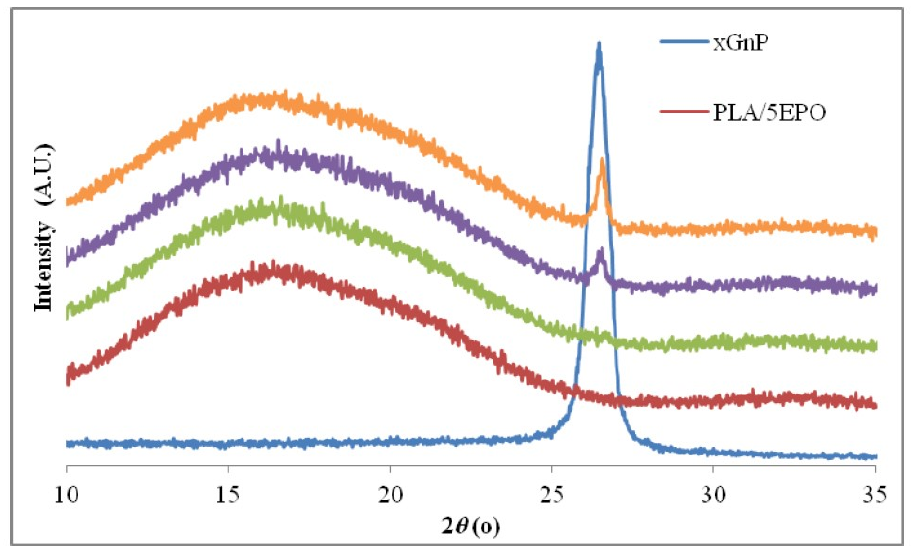
Figure 16. XRD patterns of different graphene nanocomposites. Reproduced from [183] (CC